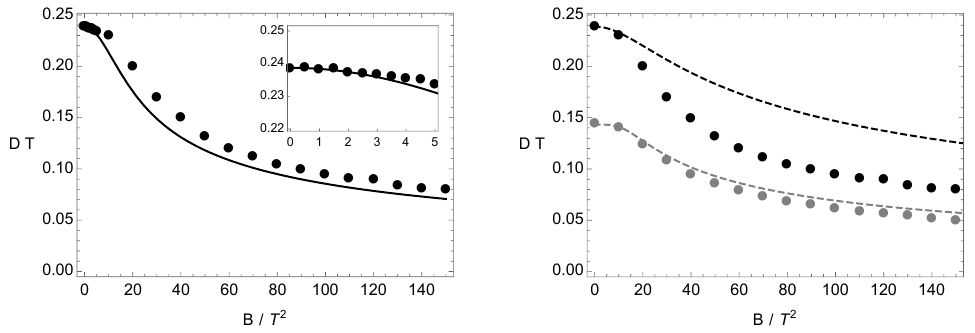
Figure 20 . The diffusion constant of the diffusive mode. Left: the result for the F 2 model with Neumann boundary conditions. The solid line is the hydrodynamic prediction which at small B is given in eq. (5.10). Right: black dots are for F 2 model and gray dots are for F 4 model with Dirichelt boundary conditions. The dashed lines are the analytic results from the perturbative bulk computation, eq. (5.13), valid at B/T 2 → 0 . The zoom shows the validity of the hydrodynamic formula for the F 2 theory with alternative b.c.s. in the limit of small magnetic